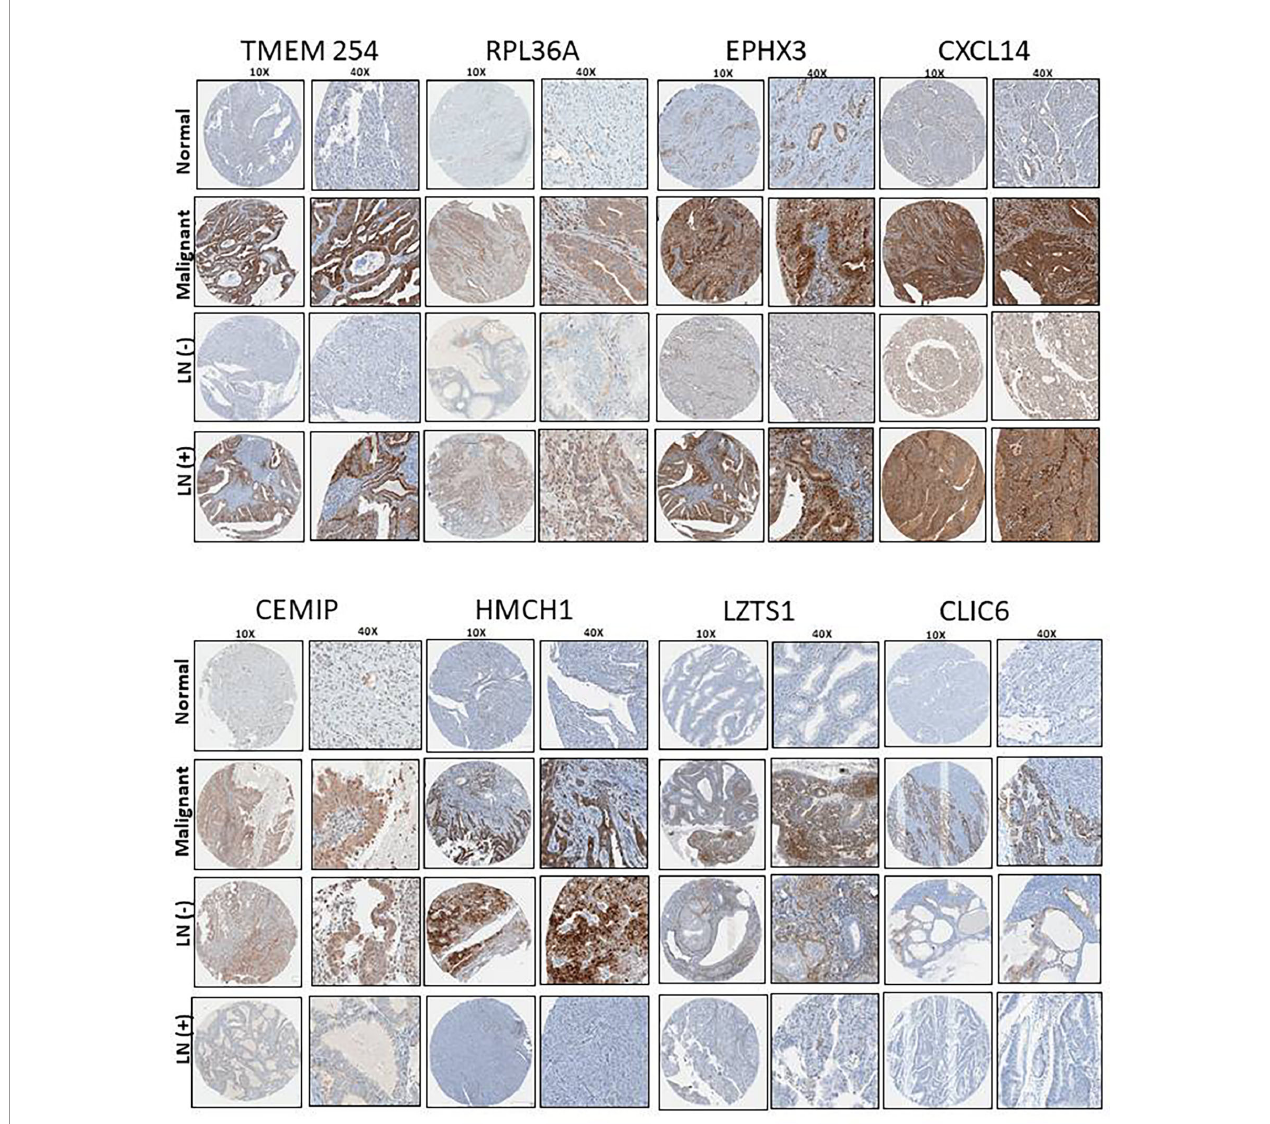
FIGURE 5 | TMA representative images (10X and 40X) of the protein expression levels of the shortlisted genes and its association with LN status in our patient cohort consisting on 35 obese patients with